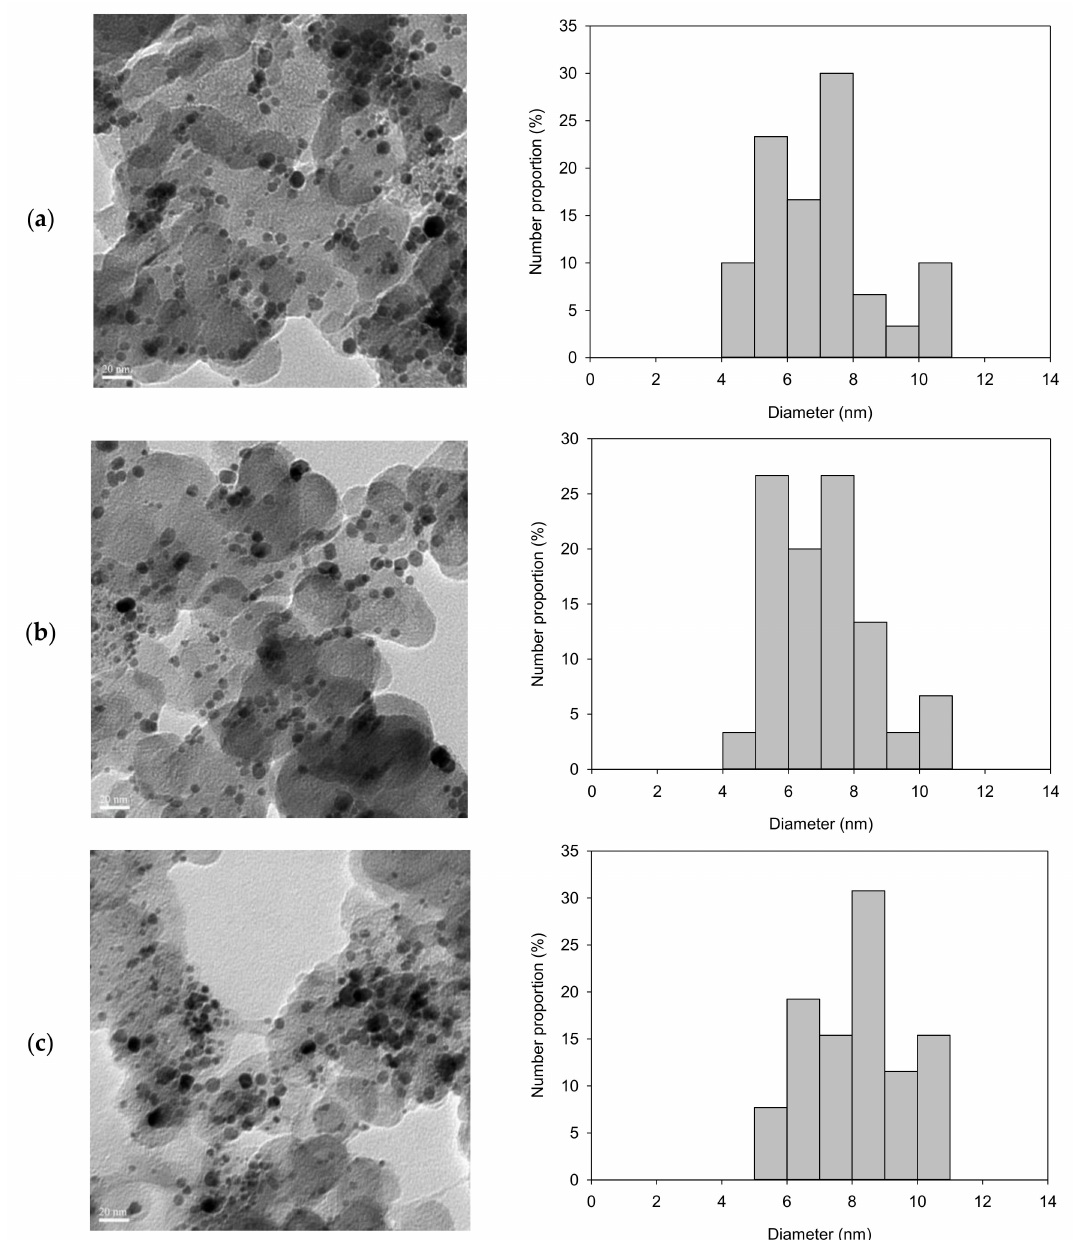
Figure 6. HR-TEM images and Pt particle-size distribution fabricated by SCD at 80 ◦ C for different time durations: ( a ) 2 h; ( b ) 4 h; and, ( c ) 6